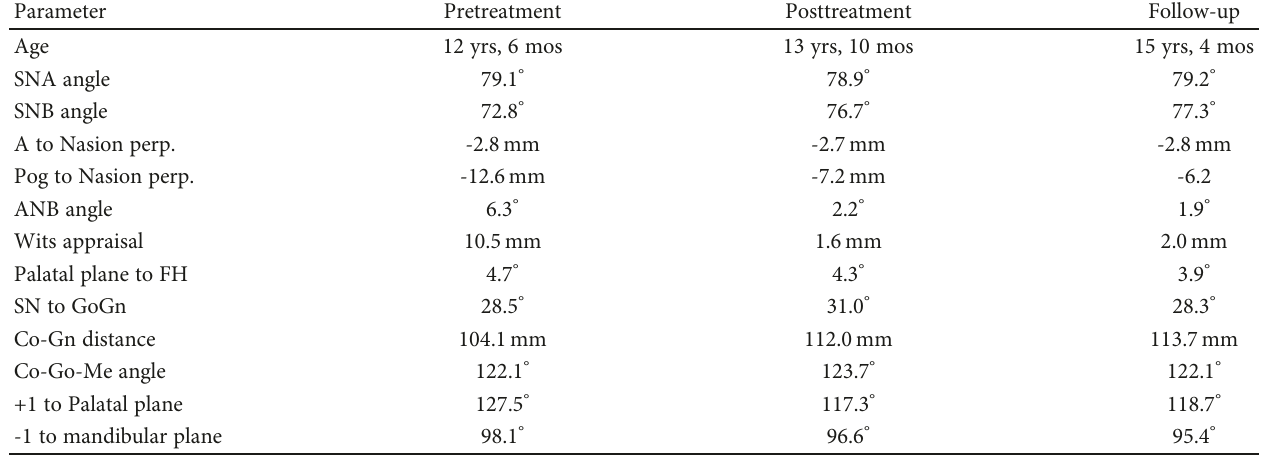
Table 1: Cephalometric data of Case